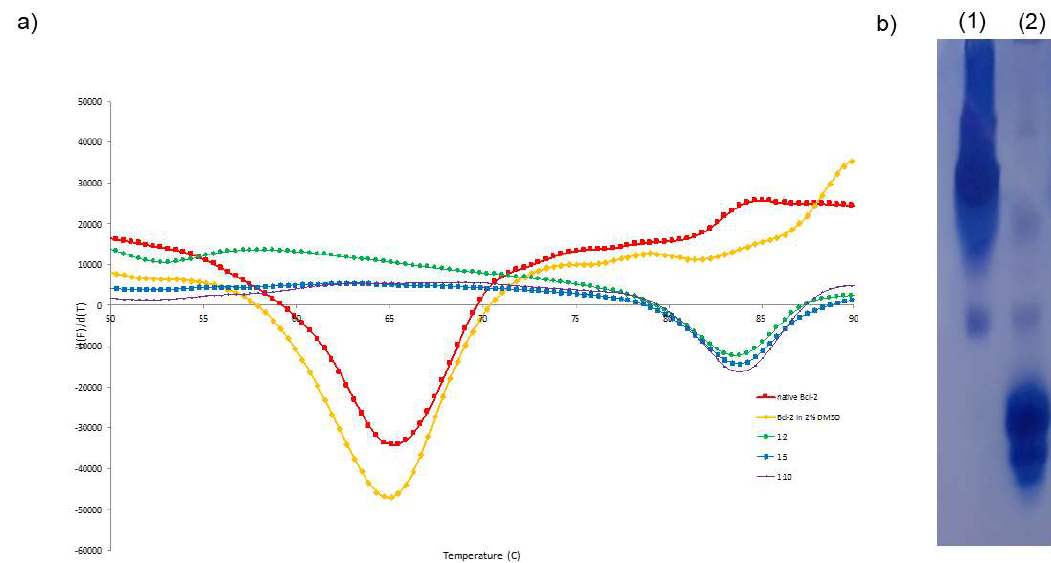
Figure 1. ( a ) TSA of chimeric Bcl-2 and incubated with venetoclax in different protein-ligand molar ratios: Bcl-2 in red, Bcl-2 with 2% DMSO in yellow, 1:2 in green, 1:5 in blue, 1:10 in pink color. Upon ligand incubation, the Bcl-2 T m shifted significantly toward higher temperatures, representing a ∆ T m = 18 °C. ( b ) Urea polyacrylamide gel of (1) Ligand free form of chimeric Bcl-2 and (2) incubated with chimeric Bcl-2:venetoclax. A great difference in electrophoretic mobility is observed in the presence of ligand, indicating relevant modifications in protein folding.